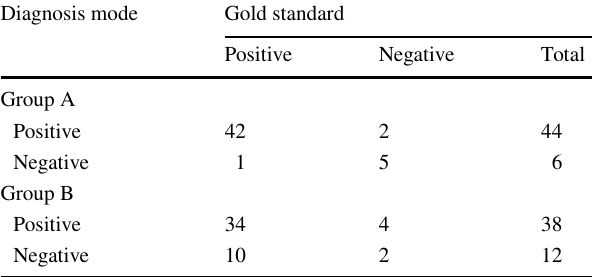
Table 3 Analysis of diagnosis results of two groups